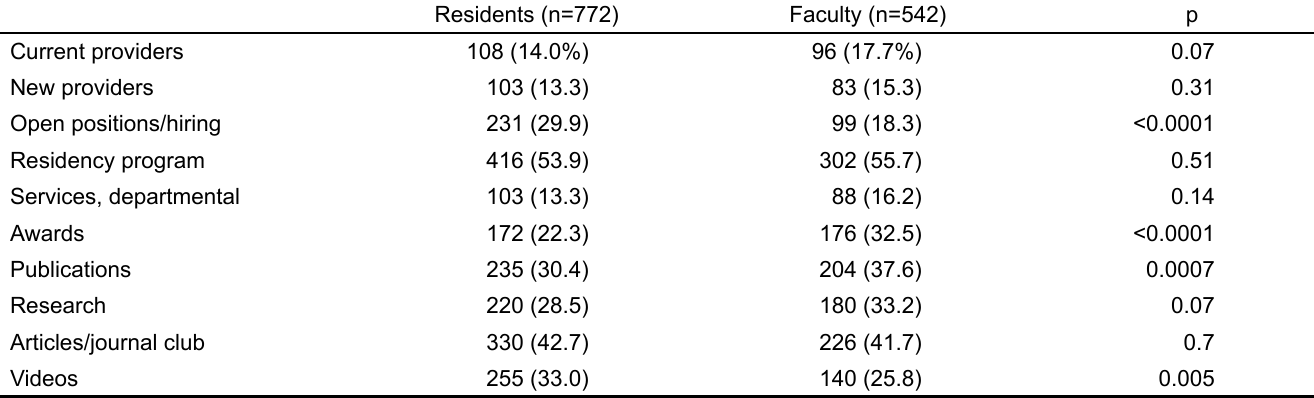
Table 6. Information of interest to residents and faculty when using social